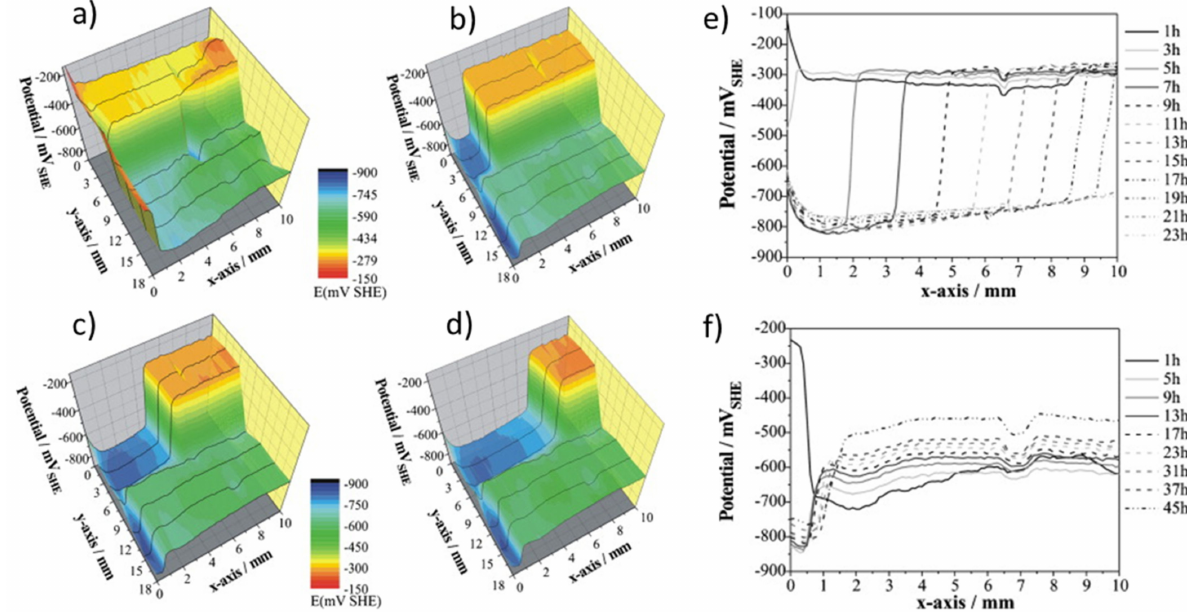
Figure 12. ( a – d ) Potential profiles during delamination for a non-pigmented, transparent polymeric film on electrogalvanized (EG) steel with (y-axis: from 6 to 18 mm) and without (y-axis: from 0 to 6 mm) a conversion layer at the interface during the cathodic delamination process as measured by the HR–SKP; ( a ) 1 h, ( b ) 5 h, ( c ) 9 h and ( d ) 13 h. SKP line scans of polymer-coated EG steel during the cathodic delamination process: ( e ) alkali-cleaned zinc surface without conversion layer and ( f ) conversion layer–coated zinc surface. Reproduced with permission of Elsevier